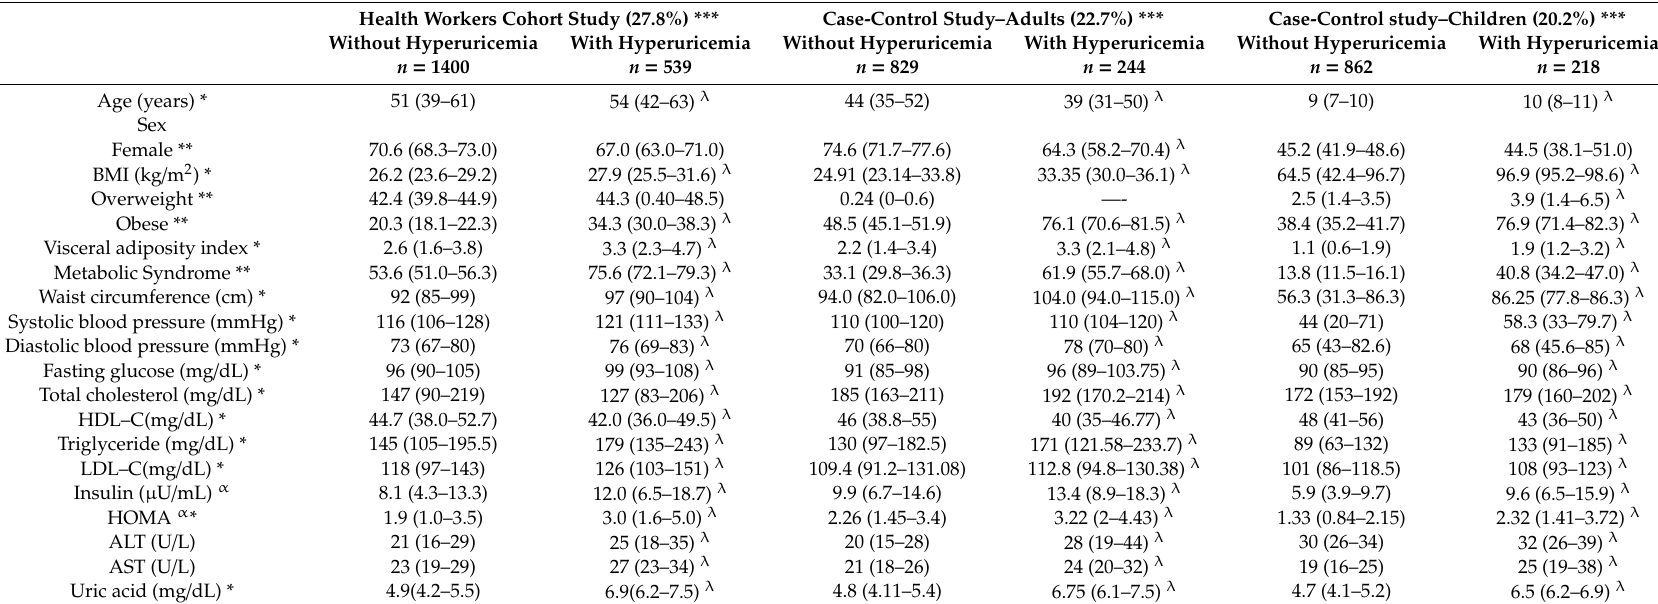
Table 1. Characteristics of study groups by hyperuricemia